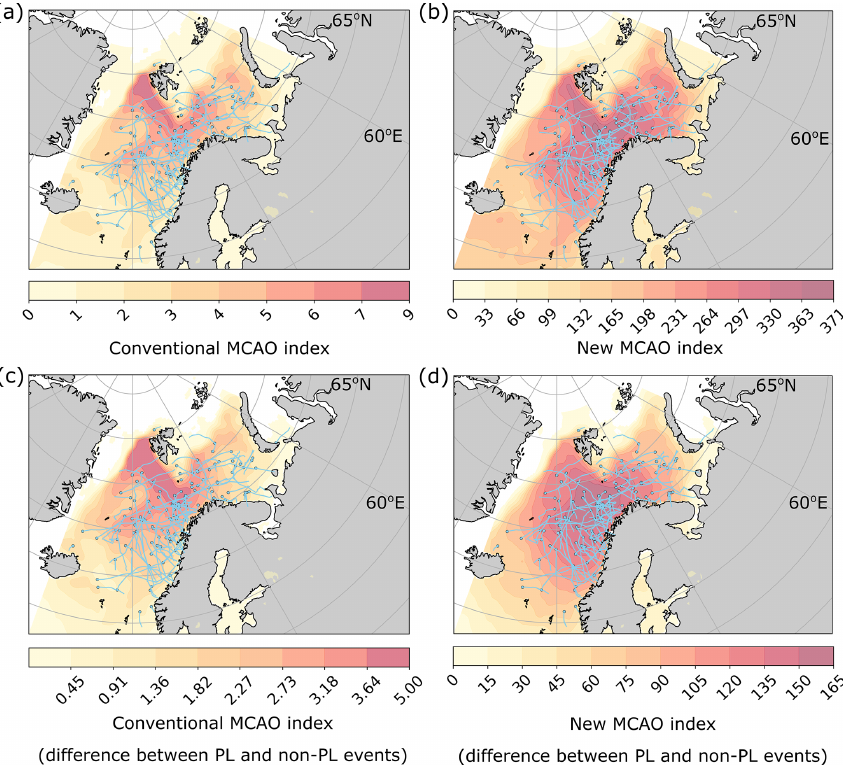
Figure 6. Composite analysis of the conventional and the new MCAO index. (a) The conventional MCAO index during all PL events. (b) The new MCAO index during all PL events. (c) Difference between the conventional MCAO index during PL events and pseudo-events. (d) Difference between the new MCAO index during PL events and pseudo-events. PL tracks are plotted as blue lines with the circle at the genesis location reported in